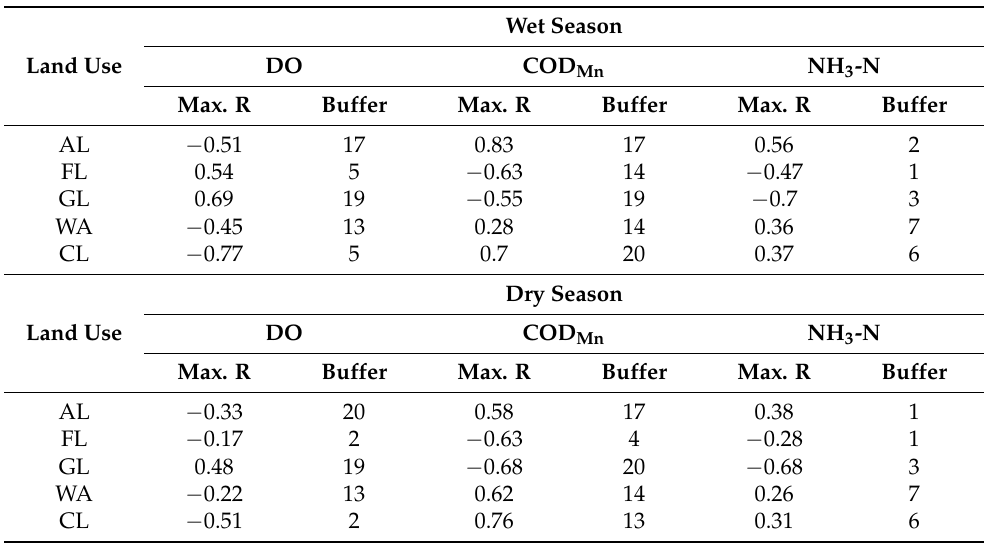
Table 4. Comparison of the maximum correlation and the buffer (S4) of land use and water quality in different